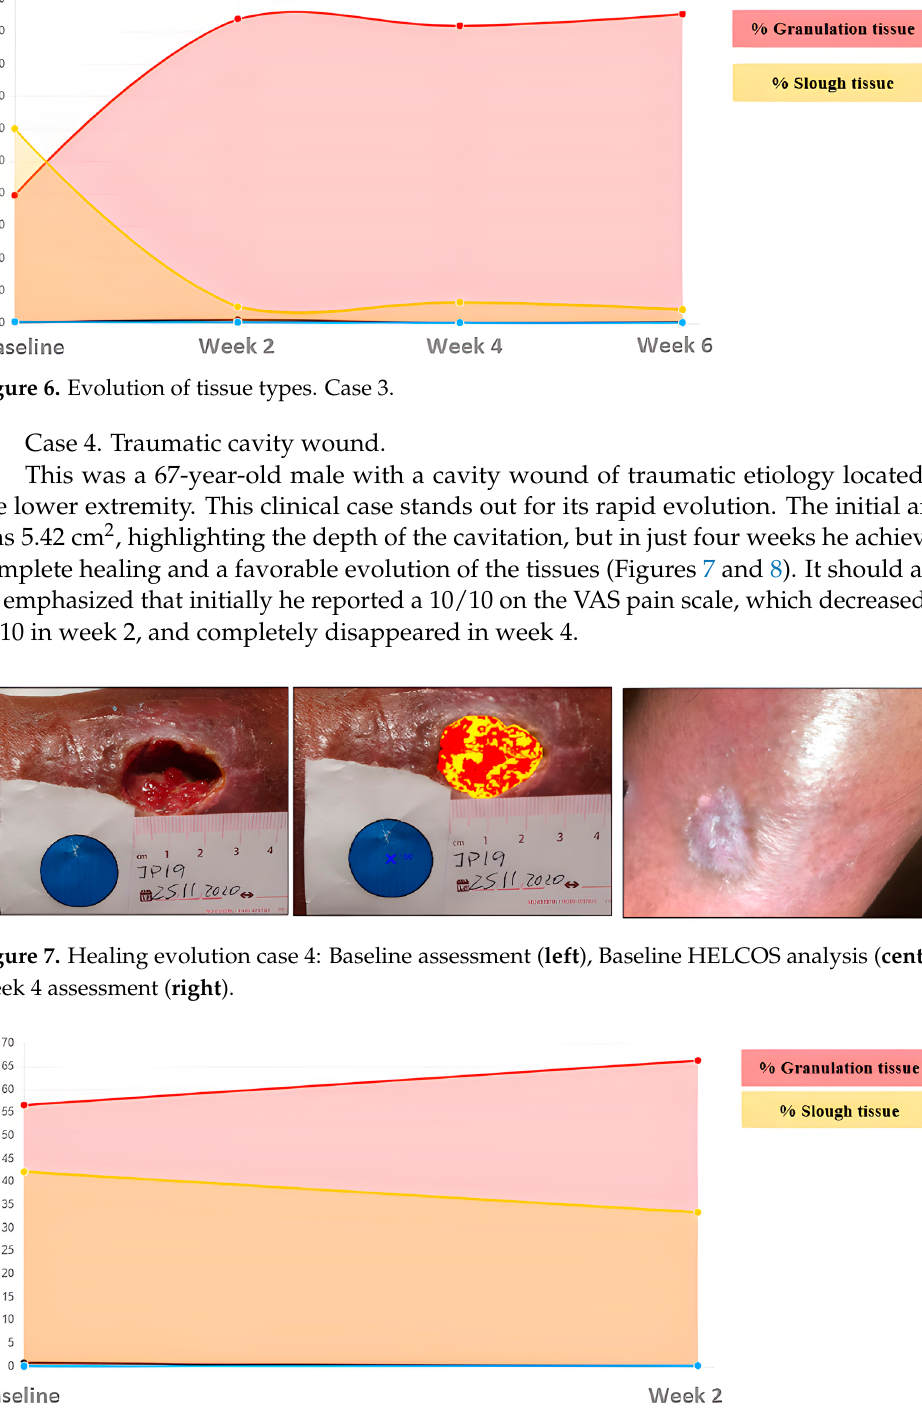
Figure 8. Evolution of tissue types. Case 4.